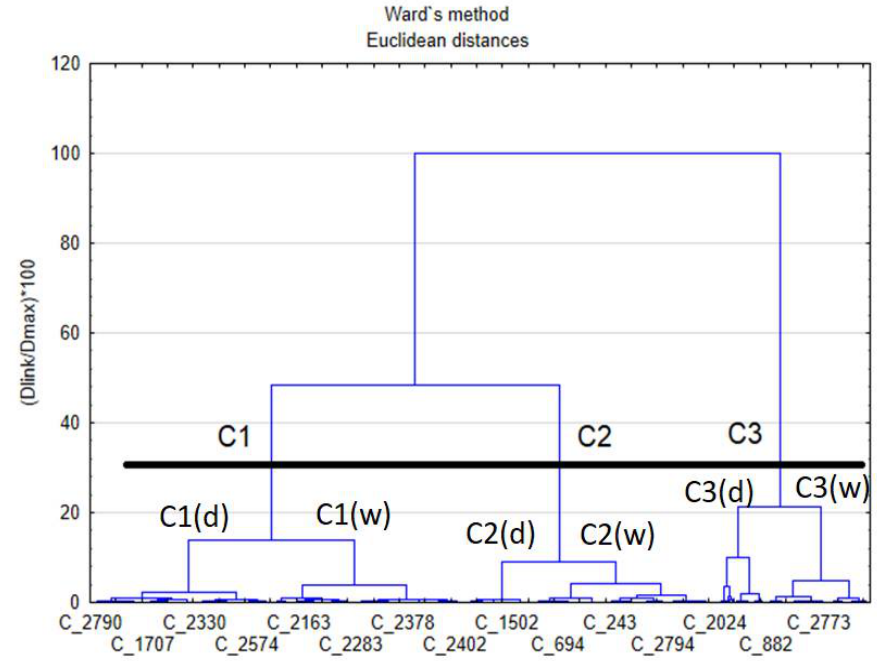
Figure 3. Results of cluster analysis for the analyzed measurement point.